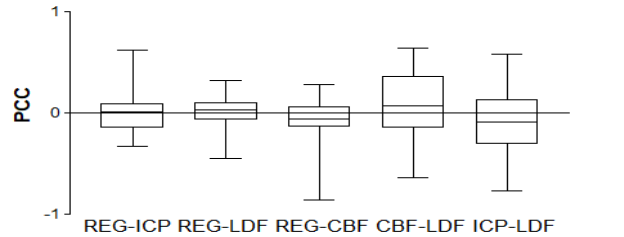
Fig. 3: Box diagram of Pearson's correlation coefficients between measured modalities. Recording of analog signals showed SAP decrease after 8 minutes and plateau at 40 mmHg during the rest the of recording (from 22 till 71 m); simultaneous decrease of mean CF, ICP, brain tissue O 2 , exhaled CO 2 concentration; transient increase of CBF, CF and pulse oximeter amplitudes; REG followed SAP decrease and showed transient increase; LDF involved artifact, was unable to visually evaluate change. Pig # 1, file # 2. Input data (time points) are representing 65